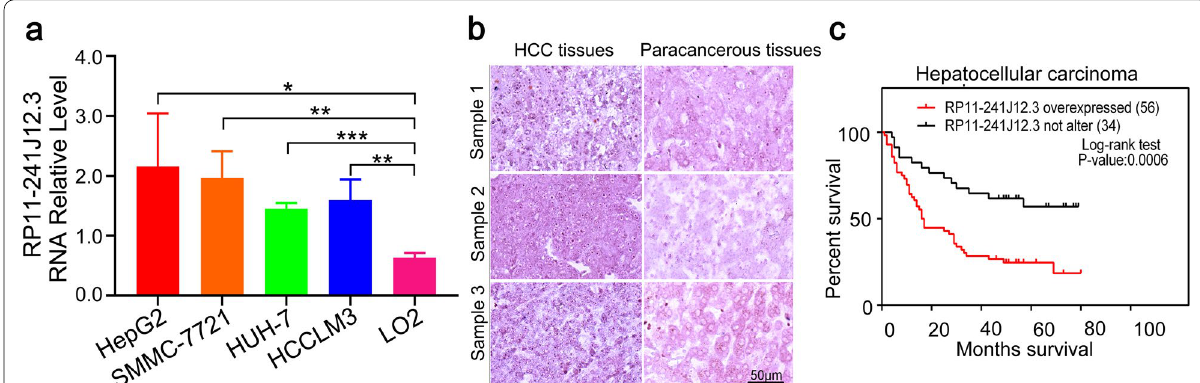
Fig. 7 RP11-241J12.3 was highly expressed in human liver tumours and closely related to survival of clinical patients. a RP11-241J12.3 expression in HepG2, HCCLM3, HUH7 SMMC-7721 and LO2 cells. qPCR analysis showing that RP11-241J12.3 is more highly expressed in HCC cells than in LO2 cells. Data are normalized to GAPDH and represent the mean SD of at least three replicate experiments. b Representative images of RP11-241J12.3 ± expression in HCC tissues and paracarcinomatous tissues. 56 out of 90 hepatocarcinoma tissues displayed high expression of RP11-241J12.3